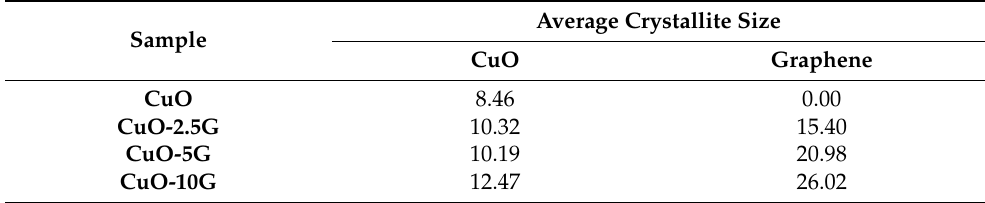
Table 3. Calculated average crystallite sizes of CuO and graphene in the synthesized samples.